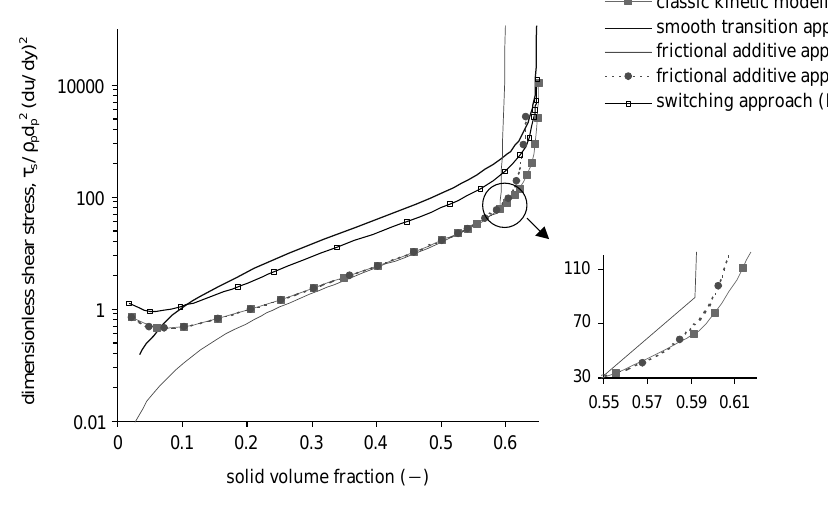
Fig. 8 Dimensionless shear stress as a function of particle concentration predicted by different modelling